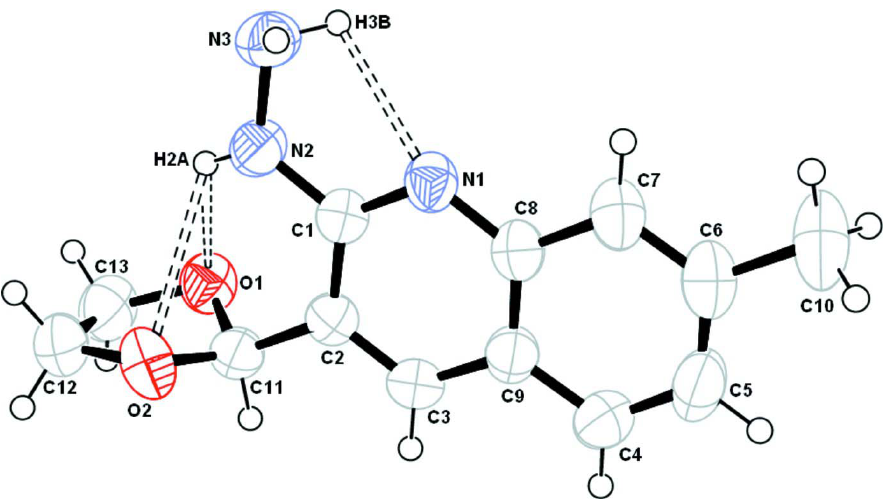
Figure 1 The molecular structure of (I) with 50% probability displacement ellipsoids. Dashed lines indicate hydrogen bonds.